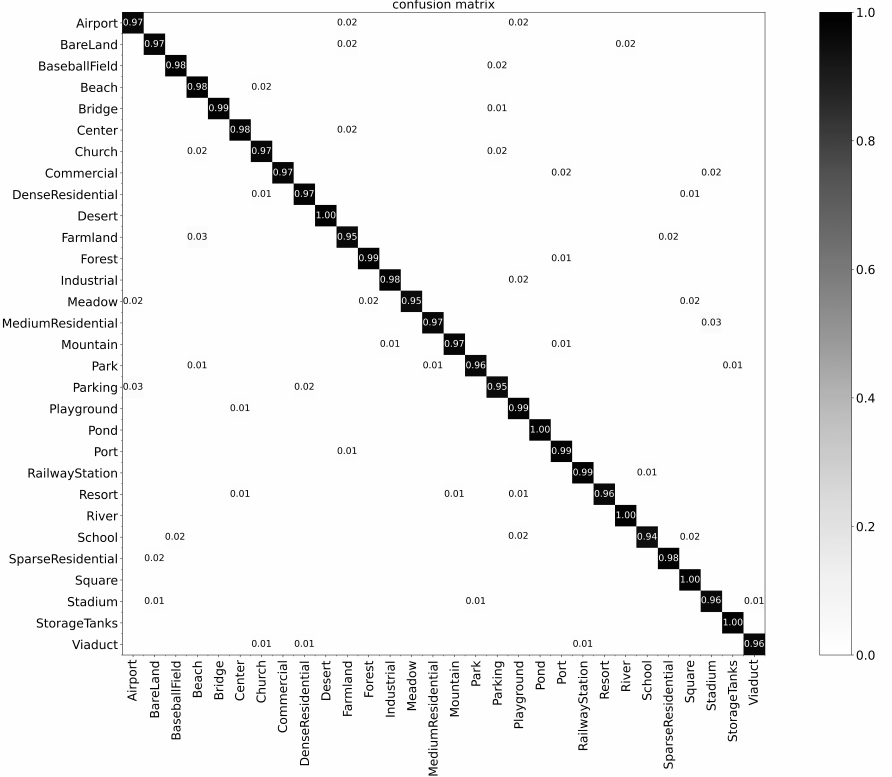
Figure 15. Confusion matrix of our method on AID dataset (train:test =